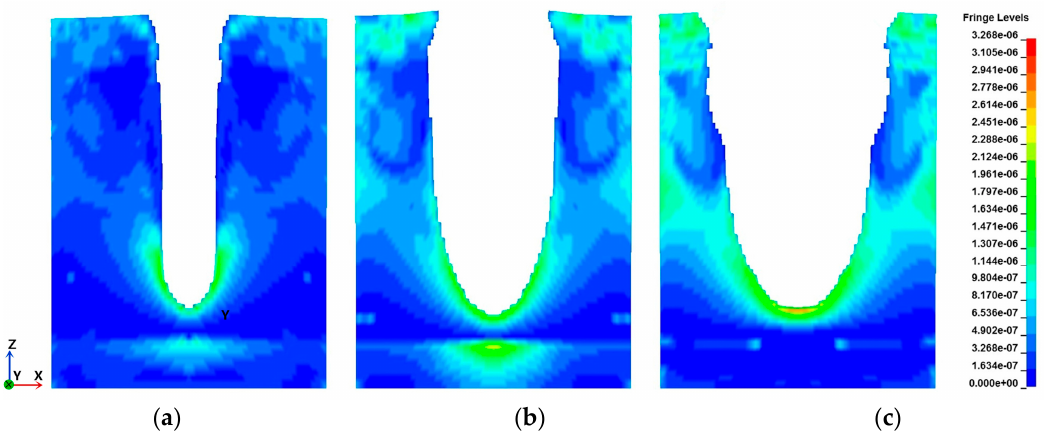
Figure 13. Stress distribution of HBS at different nozzle diameters. ( a ) D = 1.2 mm; ( b ) D = 1.8 mm ; ( c ) D = 2.4